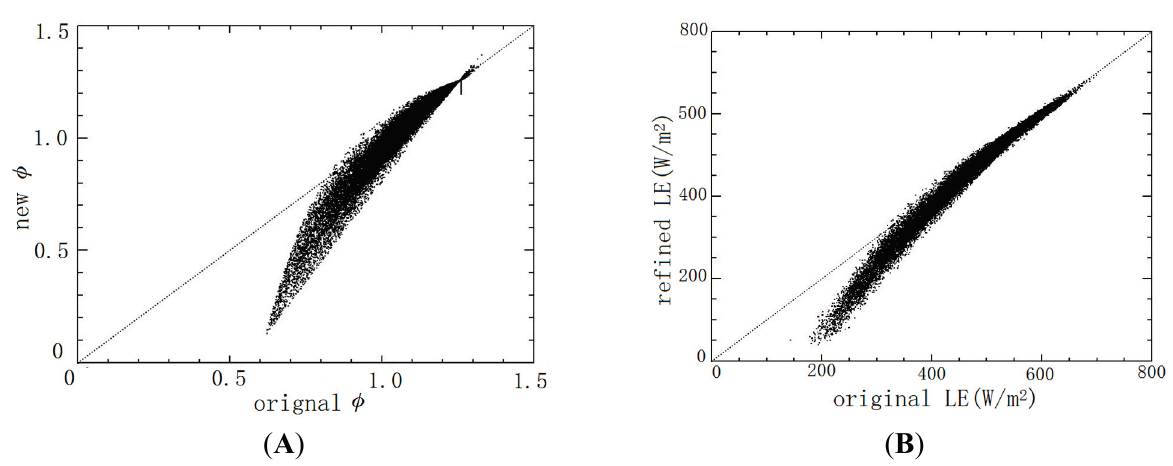
Figure 7. Comparison of original and refined result obtained from original and refined feature space: ( A ) for coefficient φ , and ( B ) for latent heat